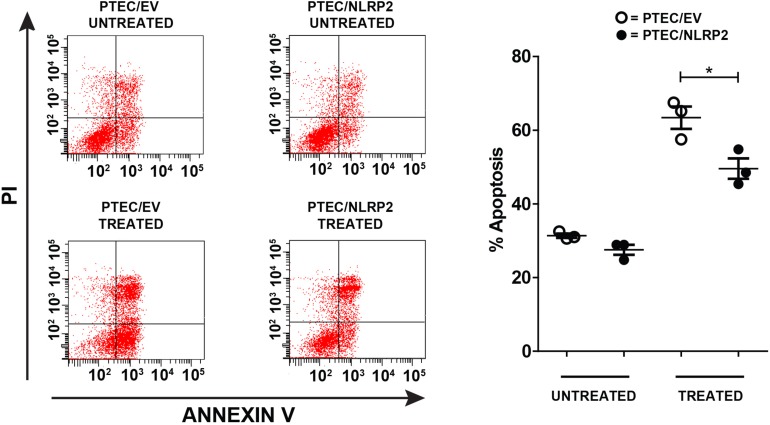
The apoptosis rate is decreased in PTEC overexpressing NLRP2. PTEC/NLRP2 and PTEC/EV were left untreated or treated with 30 ng/ml of TNF-α plus 2.5 μg/ml of Actinomycin D for 24 h. Cells were double stained with Annexin V-FITC/Propidium Iodide and apoptosis percentage was analyzed by flow cytometry. Representative scatterplots depict the Annexin V/PI stain (left panel). The apoptosis rate was calculated including early and late apoptotic cells (right panel). The data represent mean ± SEM from at least three independent experiments. ∗p < 0.05.